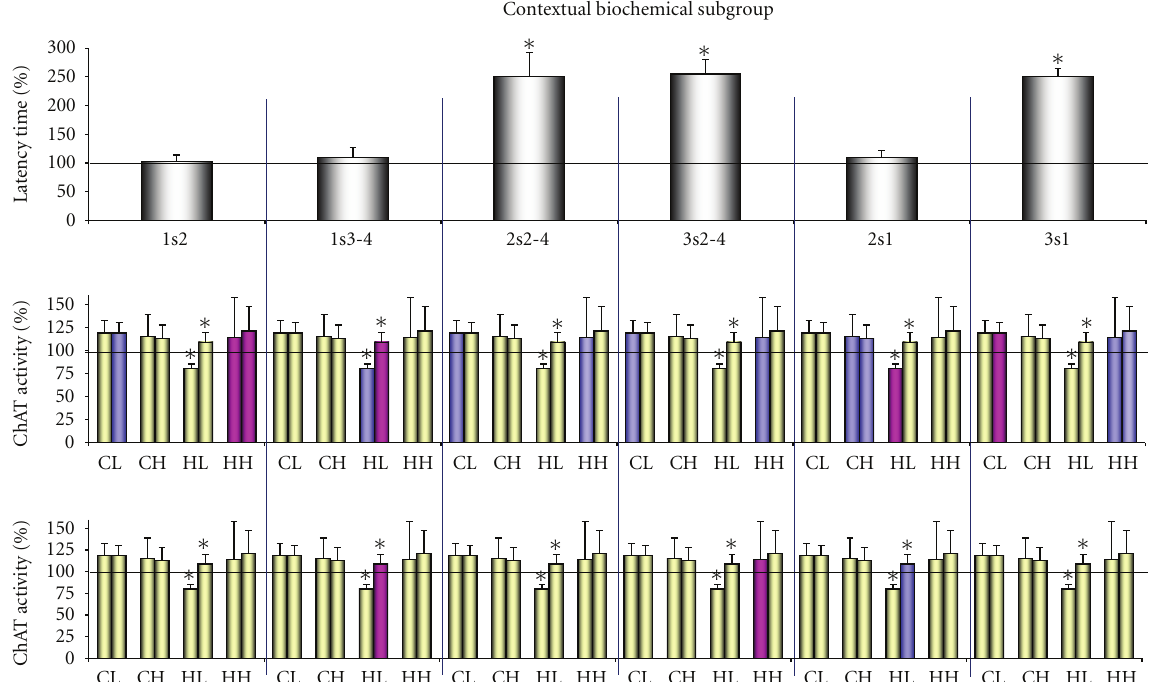
Figure 4: 2VO induced changes in behavioral performance and ChAT activity in the key cholinergic populations in the spatial contextual biochemical subgroup ( n = 5). 1s2, 1s3-4, 2s2–4, 3s2–4, 2s1 and 3s1, the same forms of cognition as in Figure 1. Behavioral performance was expressed as percentage of latency time compared to their control values (100%). CL, CH, HL, HH, the same pairs of the subfractions as in Figure 2. Values of ChAT activity in the subfractions are identical to ones in Figure 2-contextual, and they were duplicated under the each form of cognition. Blue bars, the values of ChAT activity had positive significant correlations with corresponding forms of cognition; violet bars, the values of ChAT activity had negative significant correlations with corresponding forms of cognition. In the middle row were marked correlations between behavioral performance and ChAT activity in the control rats (correlations correspond to Table 2, Sham-Contextual). In the bottom row were marked correlations between behavioral performance and ChAT activity in 2VO rats (correlations correspond to Table 2, 2VO—Contextual). ∗ , P < . 05 by the Fisher’s exact test. See comments in Section